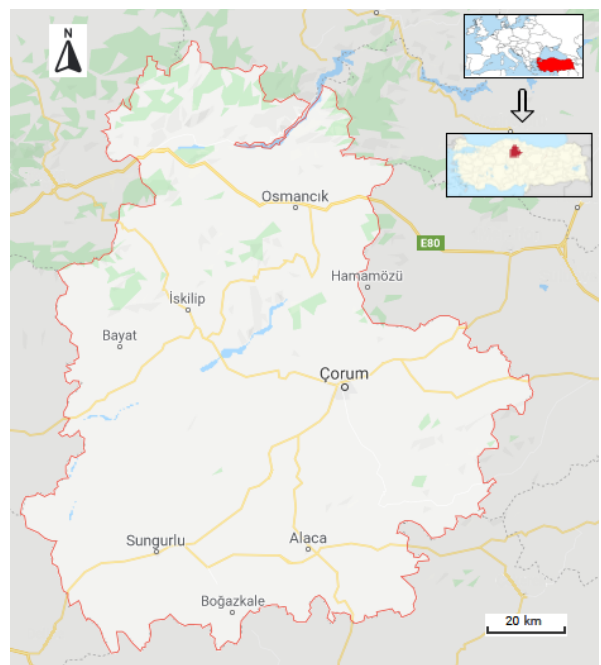
Figure 1. Location of the study area, Corum Province, Turkey (© Google